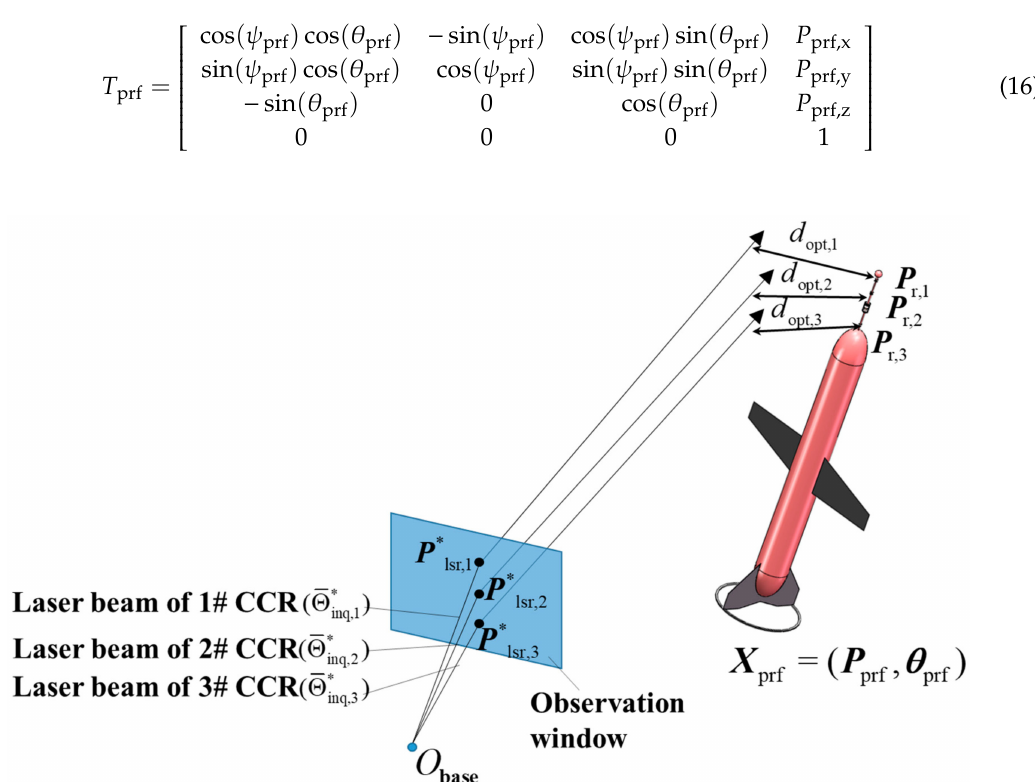
Figure 11. Illustration of the proposed fine